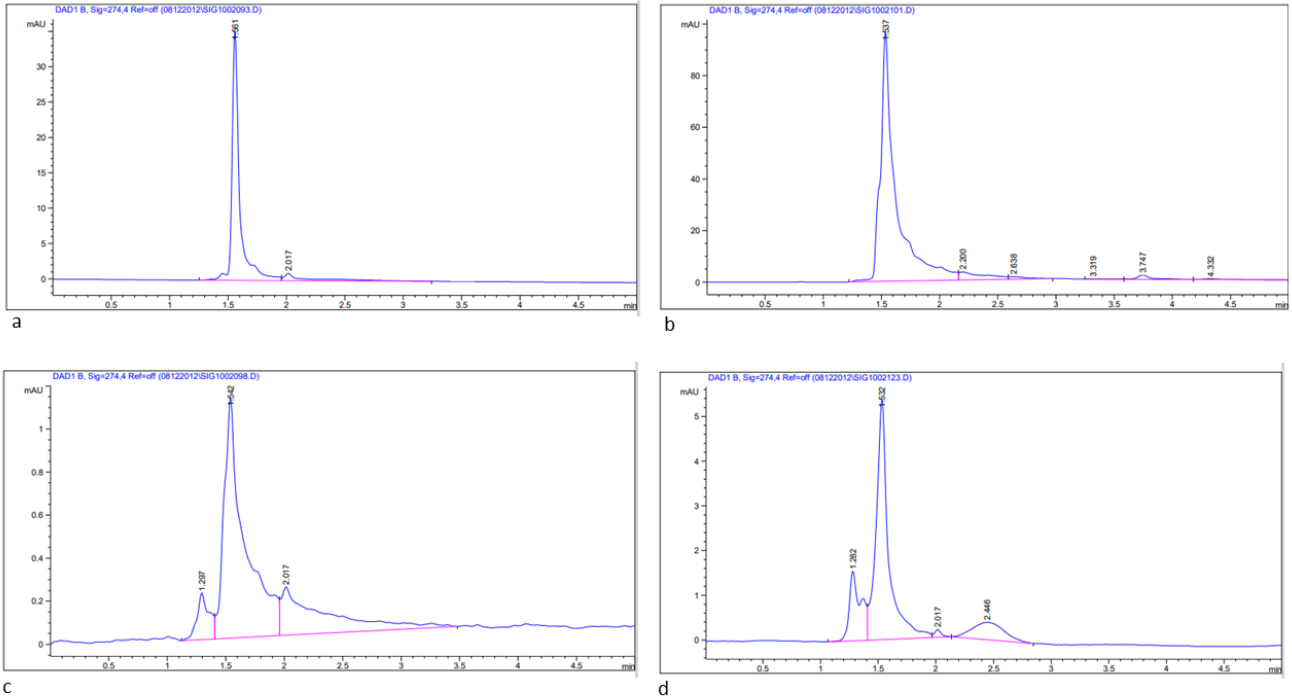
Figure 5. Total phenolic content (TPCs); ( a ); and flavonoid content (TFC); ( b ) in the young leaves of Acacia species. Values are the mean of three replicates ± S.D. Letters on bars represent the significant differences according to Duncan’s test ( p < 0.05).